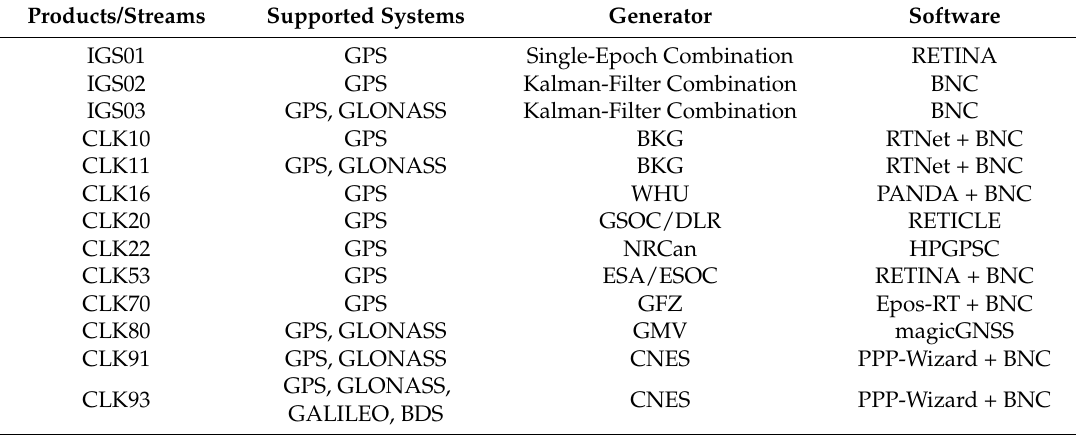
Table 1. Some APC (antenna phase center) streams of real-time SSR (state space representation) products. Products/Streams Supported Systems Generator